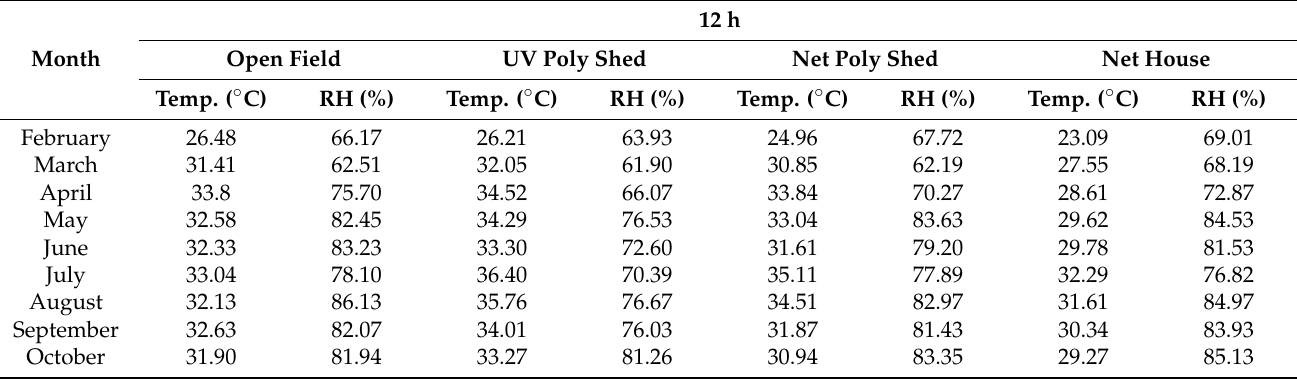
Table 1. Monthly average air temperature ( ◦ C) and relative humidity (%) at 12 h in different shed house and open field during February to October 2020.